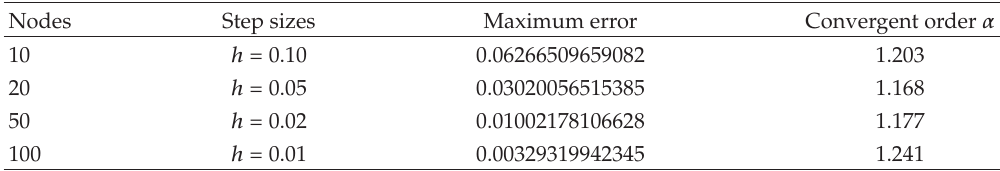
Table 1: Maximum error and convergent order of Example 4.1 with di ff erent step sizes (cid:3) computed once via the Adams-Bashforth-Moulton method (cid:4)